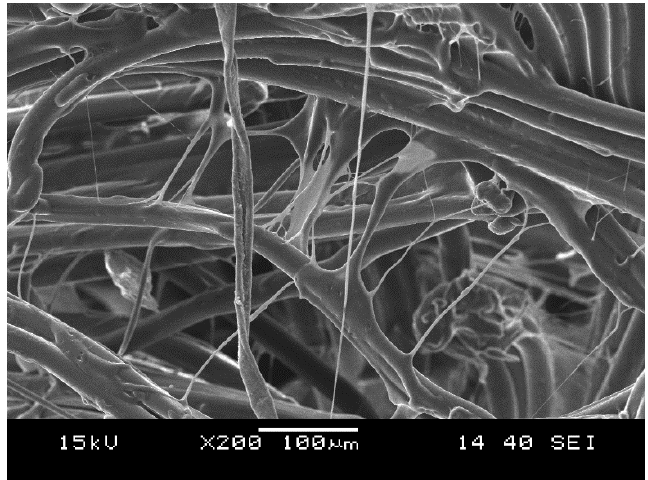
Figure 6 . Scanning electron microscopic picture of the IFWI failure surface of the APAO-3F composite